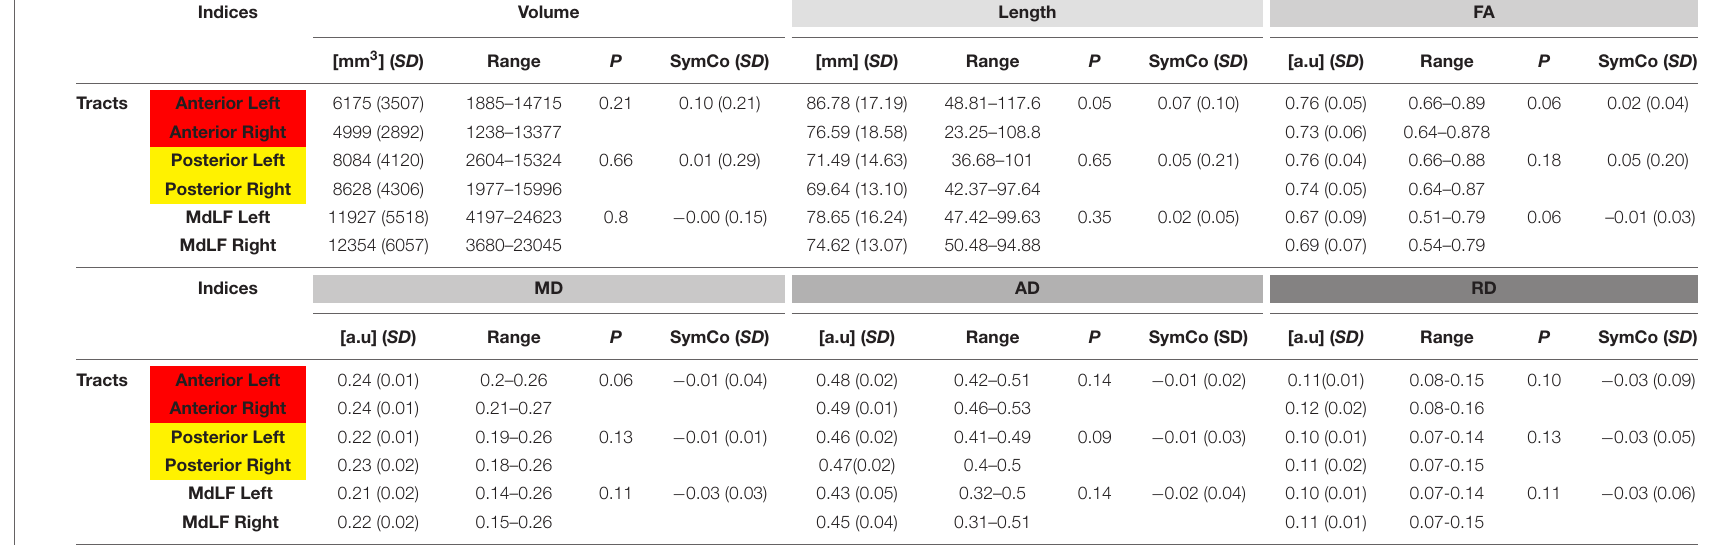
TABLE 1 | Summary of descriptive results at group level with means, standard deviations, (SD) and range for all the tracts indices (upper part with volume, tract length, tract FA-value; lower part with MD, AD, and RD) for all subgroups. Indices